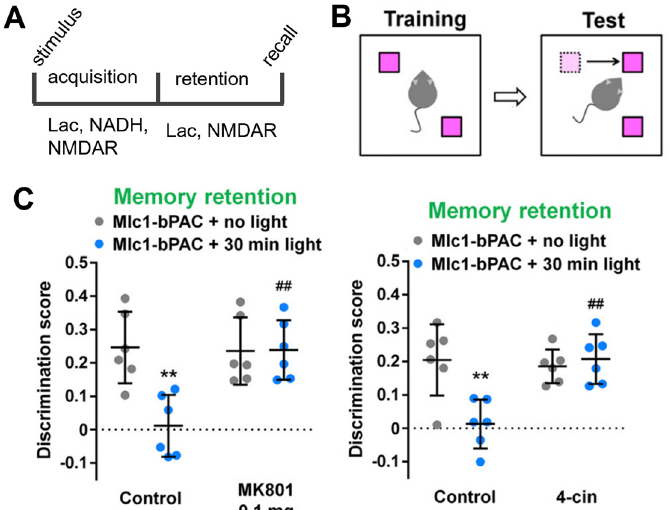
Figure 2. ( A ) Astrocyte-derived Lac is suggested to be involved in memory formation at multiple stages. ( B ) Mice were trained on a memory paradigm in which they spent more time around an object that had been moved from its previous location. Astrocytes were stimulated either during training or 24 h later using bPAC. Discrimination was assessed on day 3. Modified from [34]. ( C ) Memory test on day 3 demonstrated that optogenetic stimulation of cAMP on day 2 blocked the ability of mice to discriminate object location (second sets of data points). However, both MK 801 and 4-CIN prevented the effect of bPAC activation (fourth sets of data points), and mice performed similarly to animals which were not light stimulated (first sets of data points). Without light stimulation, MK801 and 4-CIN did not change the discrimination scores on day 3 (third sets of data points). ** p < 0.01 vs. the Mlc1-bPAC + no light + vehicle group; ## p < 0.01 vs. the Mlc1-bPAC + light + vehicle group by Tukey’s test after one-way ANOVA. Modified from [34].